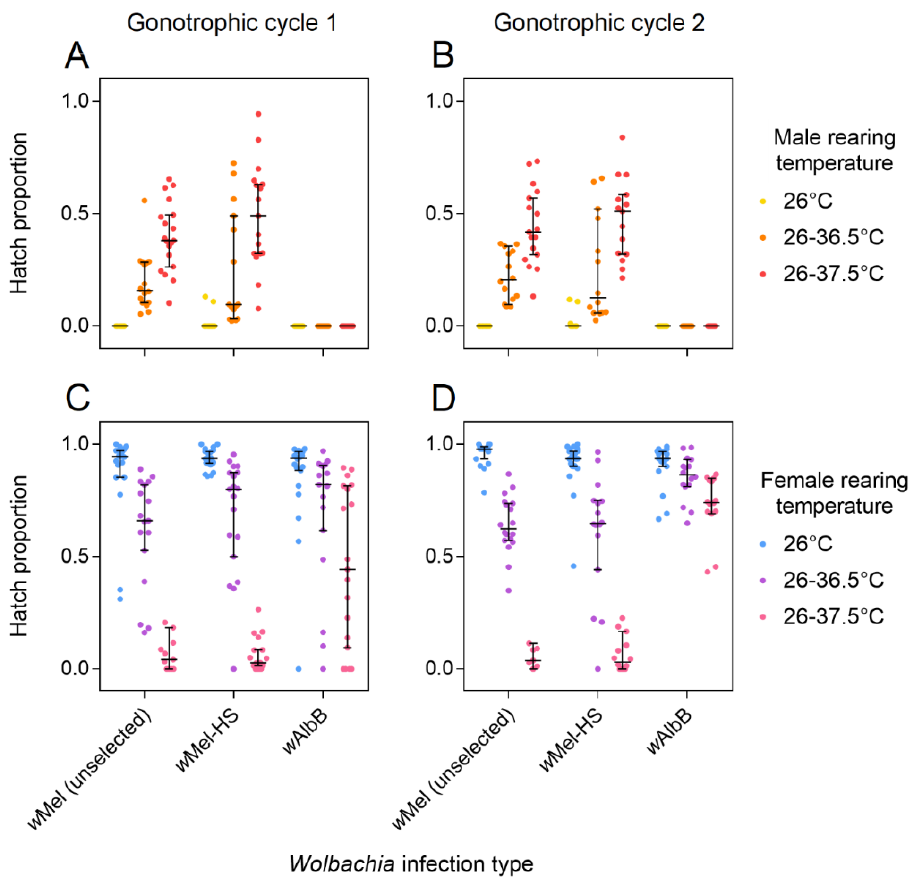
Figure 1. The ability of w Mel to induce cytoplasmic incompatibility and restore compatibility under heat stress after five generations of selection. Males ( A , B ) and females ( C , D ) from the w Mel (unselected), w Mel-HS ( w Mel heat-selected strain) and w AlbB lines were reared at a constant 26 ◦ C, or held in incubators that cycled diurnally between 26 ◦ C and 36.5 ◦ C or 26 ◦ C and 37.5 ◦ C. ( A , B ) Males reared at each temperature were crossed to uninfected females to test their ability to induce cytoplasmic incompatibility. Egg hatch proportions were measured over both the first ( A ) and second ( B ) gonotrophic cycles. ( C , D ) Females reared at each temperature were crossed to infected males reared at 26 ◦ C to test their ability to restore compatibility. Egg hatch proportions were measured over both the first ( C ) and second ( D ) gonotrophic cycles. Black bars indicate median egg hatch proportions with 95% confidence